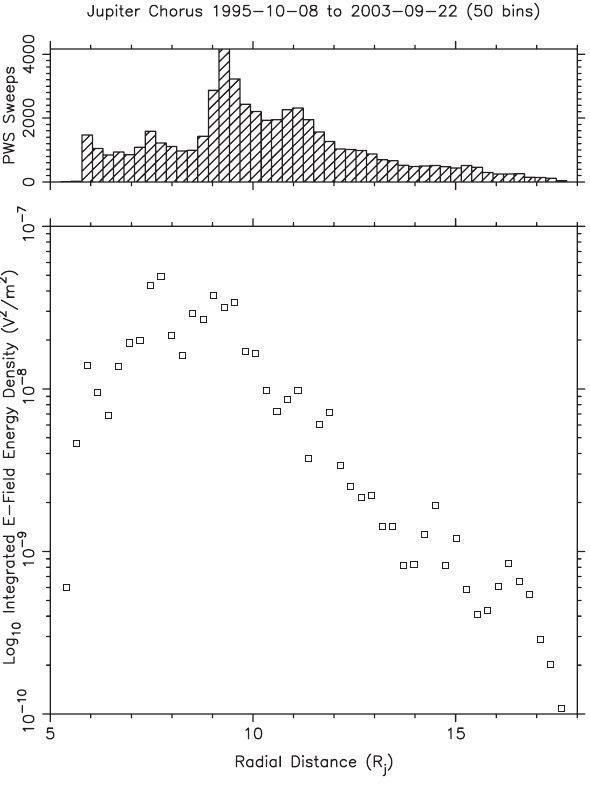
Fig. 6. Integrated chorus power as a function of magnetic